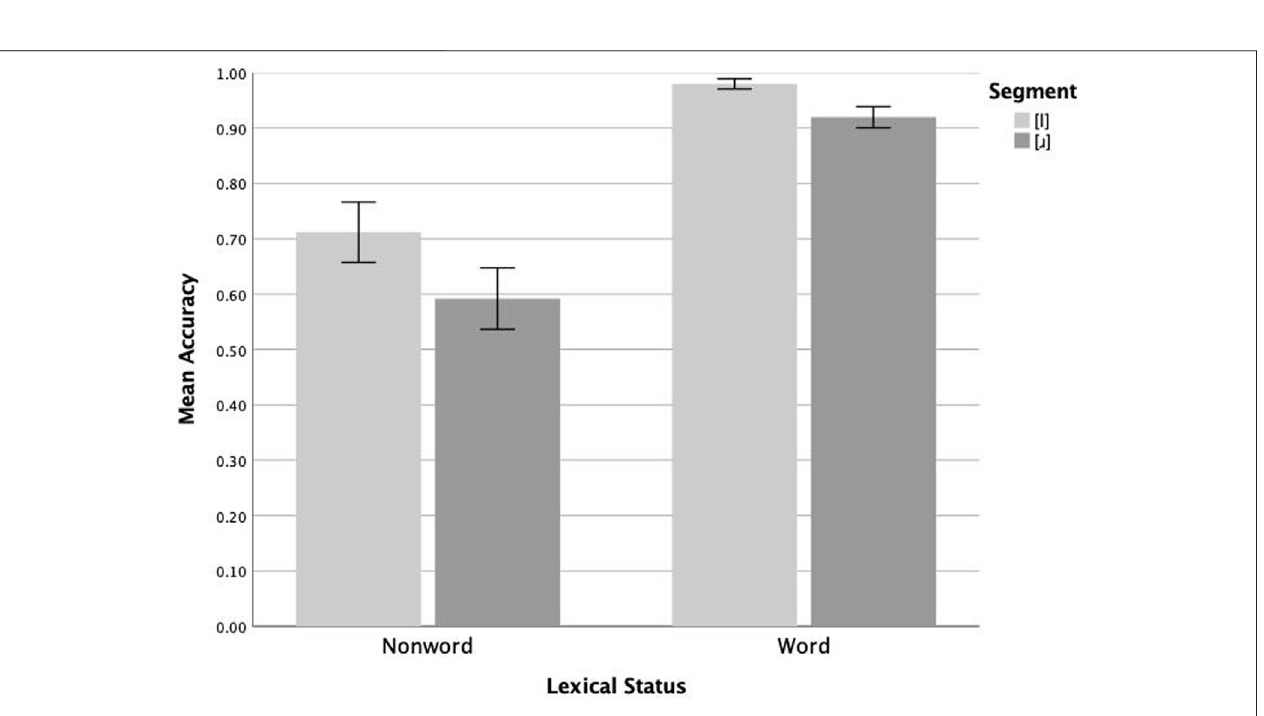
Frontiers in Communication |